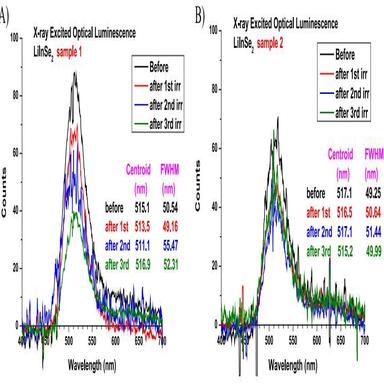
LiInSe2 emission spectra of the two samples measured before and after each irradiation.